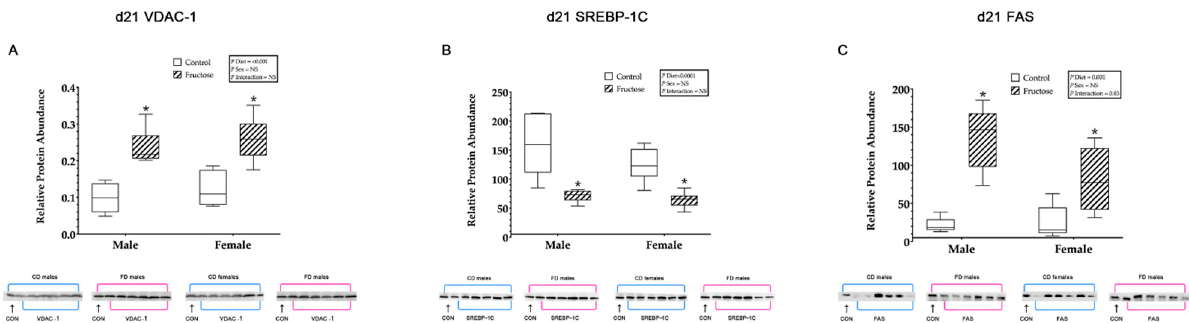
Figure 5. ( A – C ) Weanling offspring hepatic proteins. Weanling offspring control males ( n = 6); fructose males ( n = 6); control females ( n = 6) and fructose females ( n = 6). ( A ) Represents weanling offspring hepatic VDAC1 relative protein abundance and Western blot image at D21. ( B ) Represents weanling offspring hepatic SREBP-1c relative protein abundance and Western blot image at D21. ( C ) Represents weanling offspring hepatic FAS relative protein abundance and Western blot image at D21. All data were analysed using a 2 × 2 factorial design with diet*sex*interaction include as factors (general analysis of variance) using IBM SPSS statistics 25. Data presented as group mean ± SEM. * denotes significance of p < 0.05.